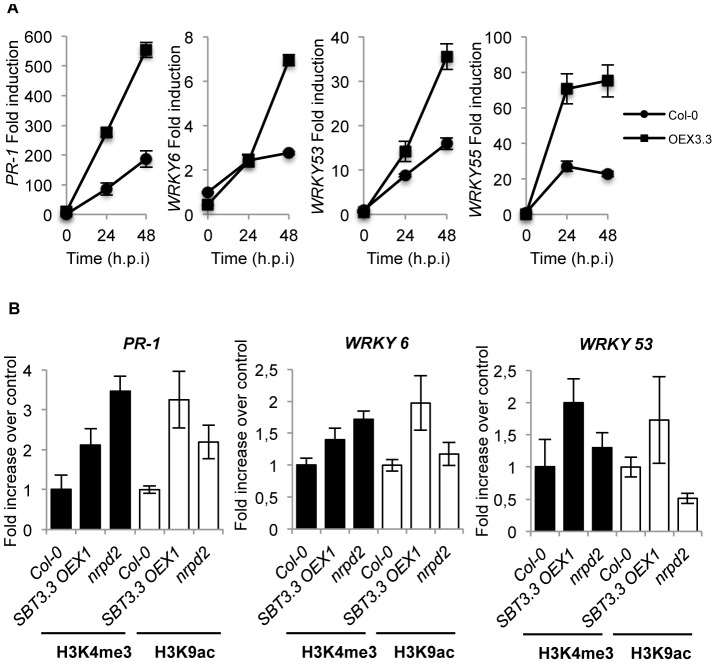
SBT3.3 expression poises SA-mediated defense genes for enhanced activation.(A) RT-qPCR of PR-1, WRKY6, WRKY53 and WRKY55 transcript levels following inoculation with PsDC3000 in Col-0 and SBT3.3OEX1 plants. Data represent the mean ± SD; n = 3 replicates. (B) Comparative level of histone H3 Lys4 trimethylation (H3K4me3) and histone H3 K9 acetylation (H3K9ac) on the PR-1, WRKY6 and WRKY53 gene promoters as present in leaf samples from Col-0, SBT3.3OEX1 and nrpd2 plants. Data are standardized for Col-0 histone modification levels. Data represent the mean ± SD; n = 3 biological replicates. Expression was normalized to the expression of the constitutive ACT2 gene.